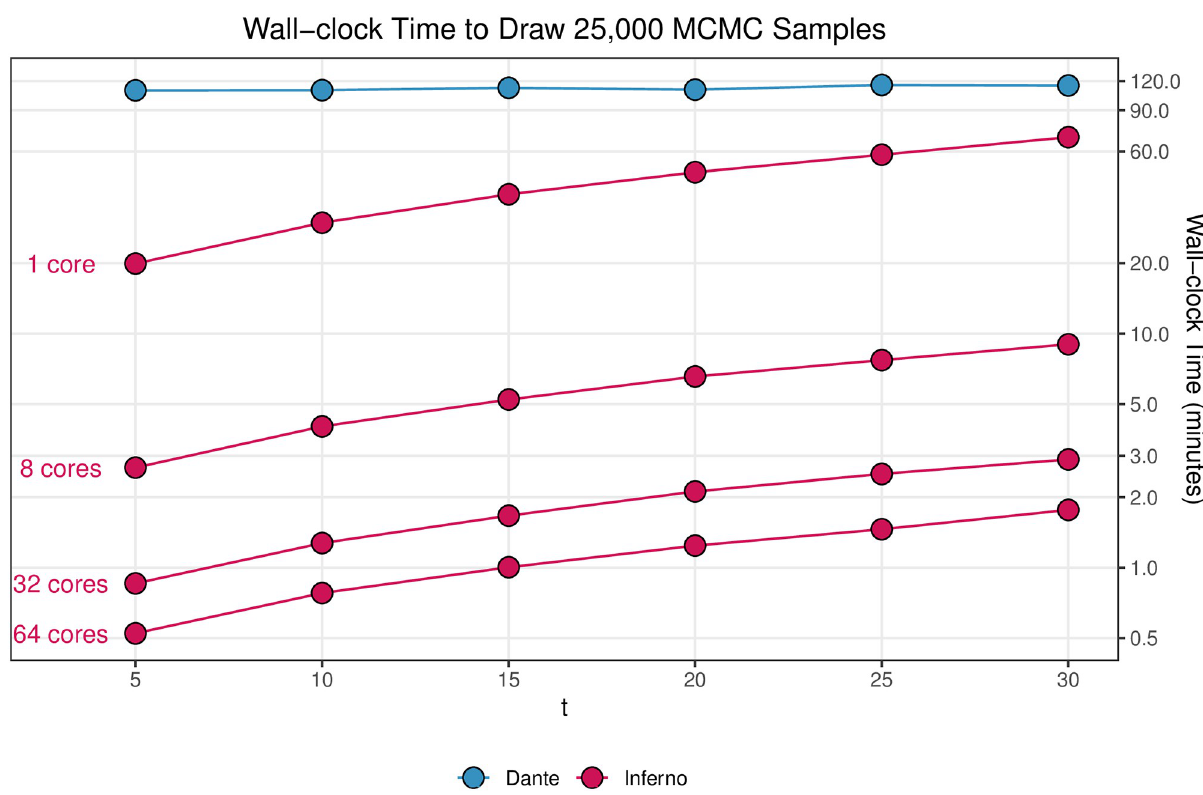
Fig 14. The wall-clock runtime of Inferno (red) and Dante (blue) to draw 25,000 MCMC samples for all 64 geographies. The red lines correspond to the runtime of Inferno based on 1, 8, 32, or 64 computing cores. Total runtime decreases as the number of cores increases. Total runtime increases as the size of the conditioning data increases for both Dante and Inferno. Dante draws 25,000 MCMC samples for all 64 geographies in 110 to 120 minutes. Dante’s reported runtimes are not monotonically increasing due to noise, as only one run was performed at each t . With 64 cores, it takes Inferno between 30 seconds and 2 minutes to draw 25,000 MCMC samples for all 64 geographies. When all 64 geographies of Inferno are run serially (1 core), Inferno takes between 20 and 70 minutes.